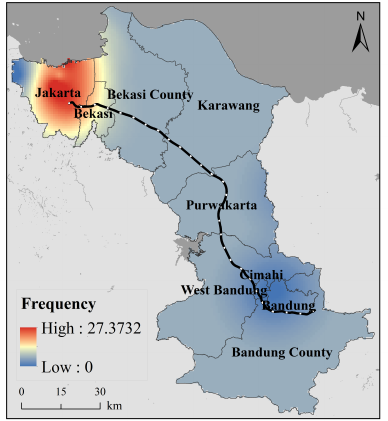
Figure A3. Map of frequency of historical heat